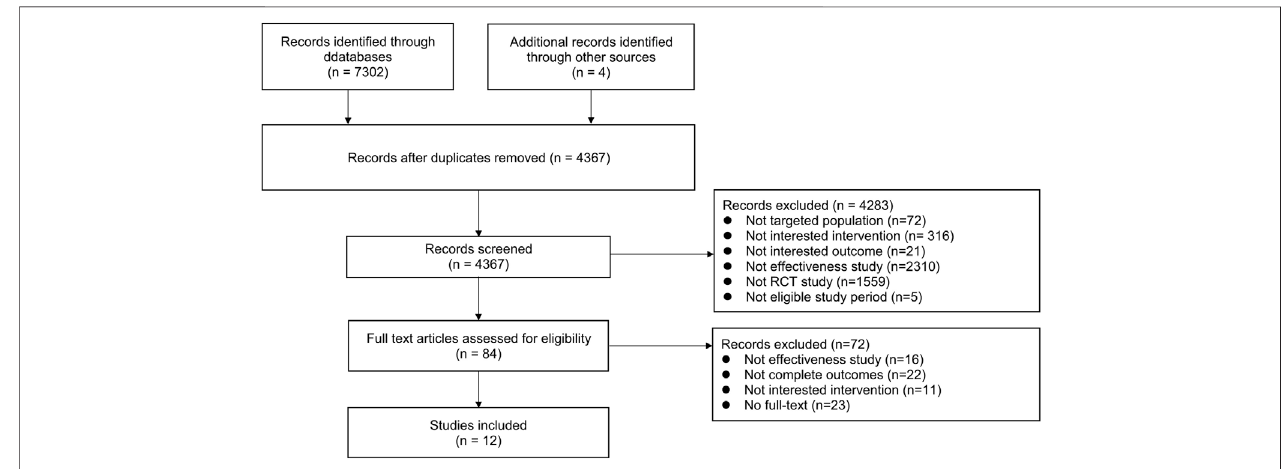
FIGURE 1 | Flowchart for selection of studies.